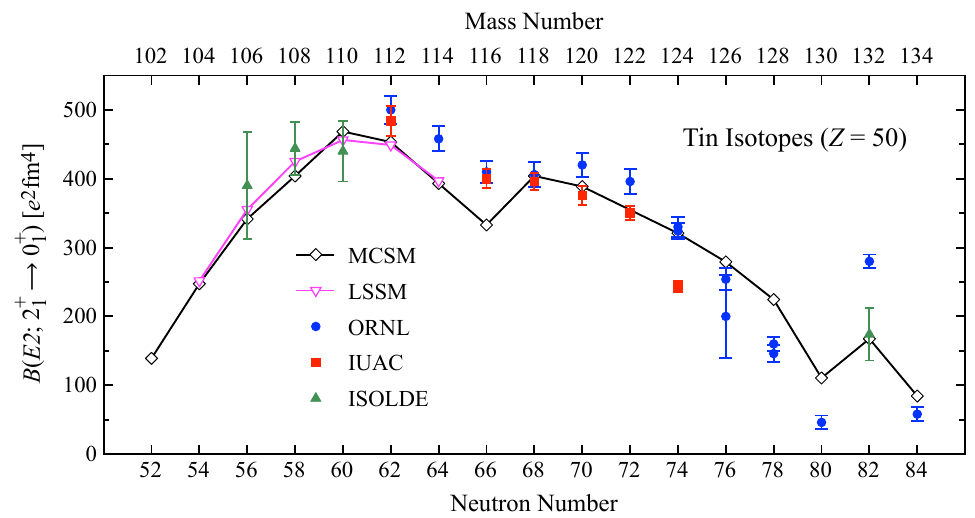
) in the Sn isotopic chain deter- 0 + 1 → 1